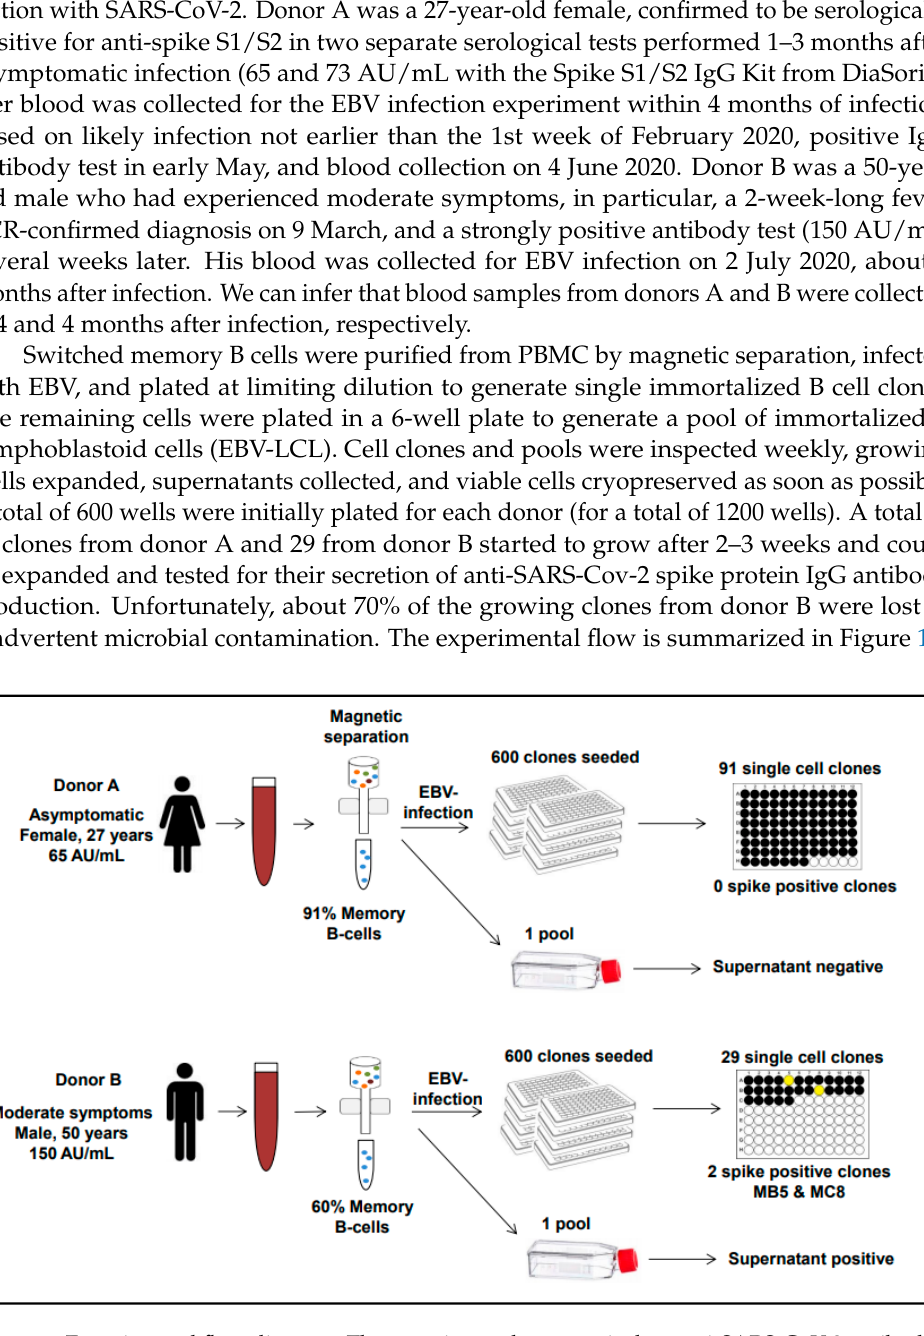
Figure 1. Experimental flow diagram. The experimental setup to isolate anti-SARS-CoV-2 antibodies is summarized for each donor.